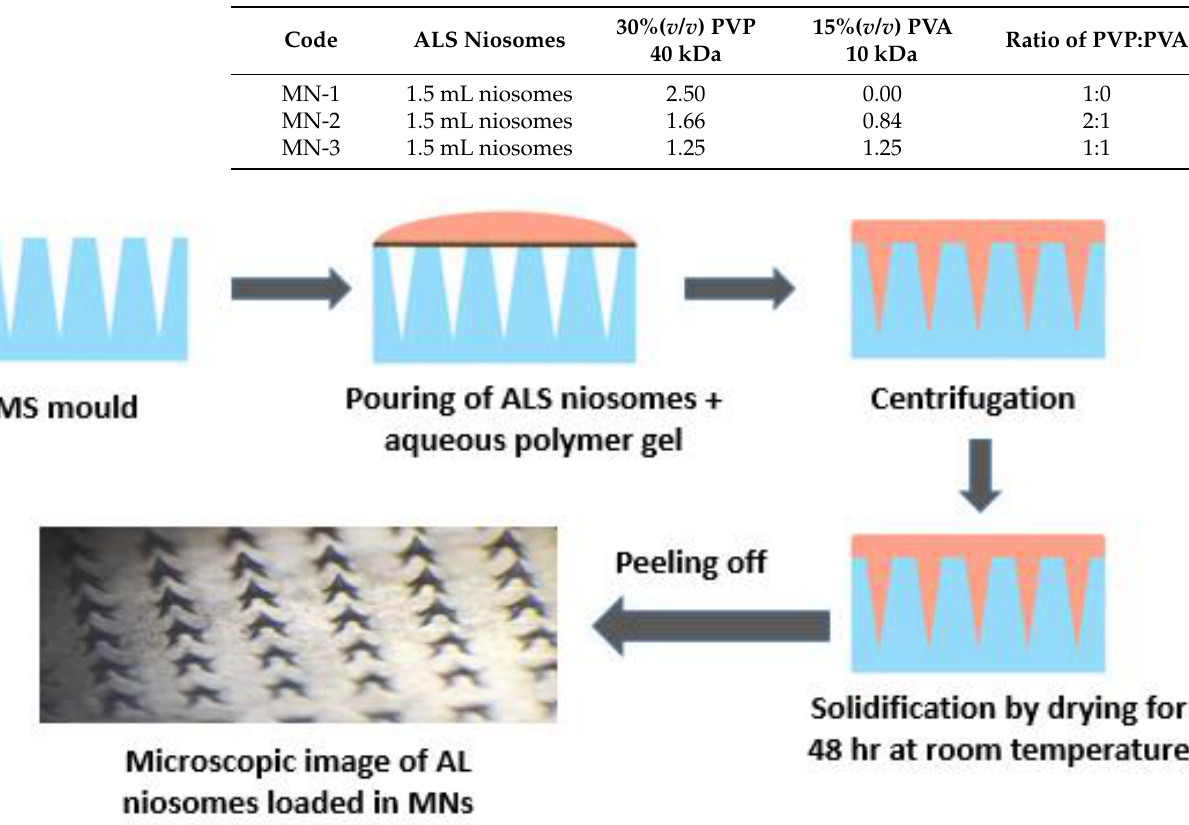
Figure 1. Schematic representation of the fabrication of ALS-loaded niosomes in MNs.